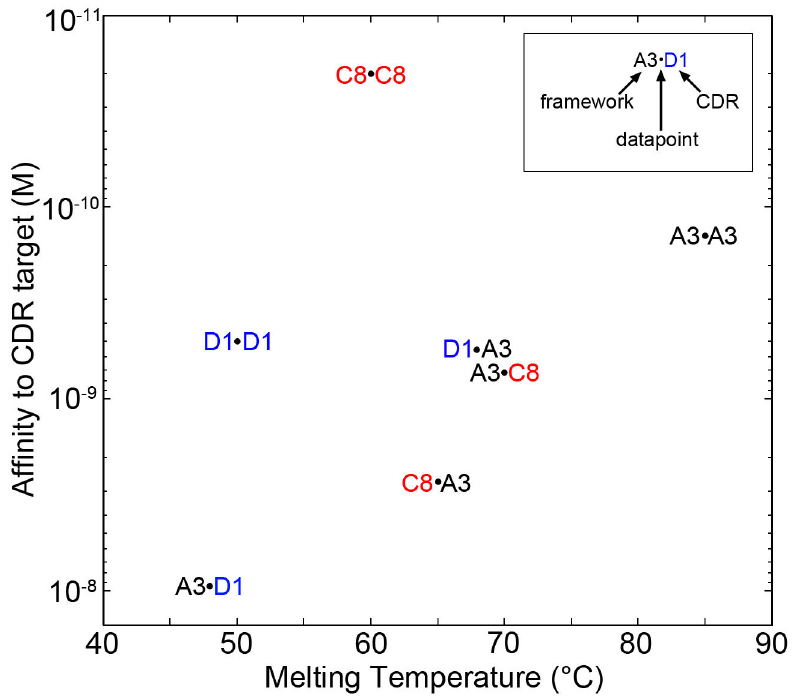
Figure 2. CDR swaps lower affinity but may increase or decrease melting temperature. Melting temperature for sdAbs A3, D1 and C8, as well as full CDR swaps, are plotted against affinity. For each data point the framework origin is indicated before the dot while the CDR origin is indicated after the dot. The affinity shown is that towards the target specified for the CDR origin antibody. doi: